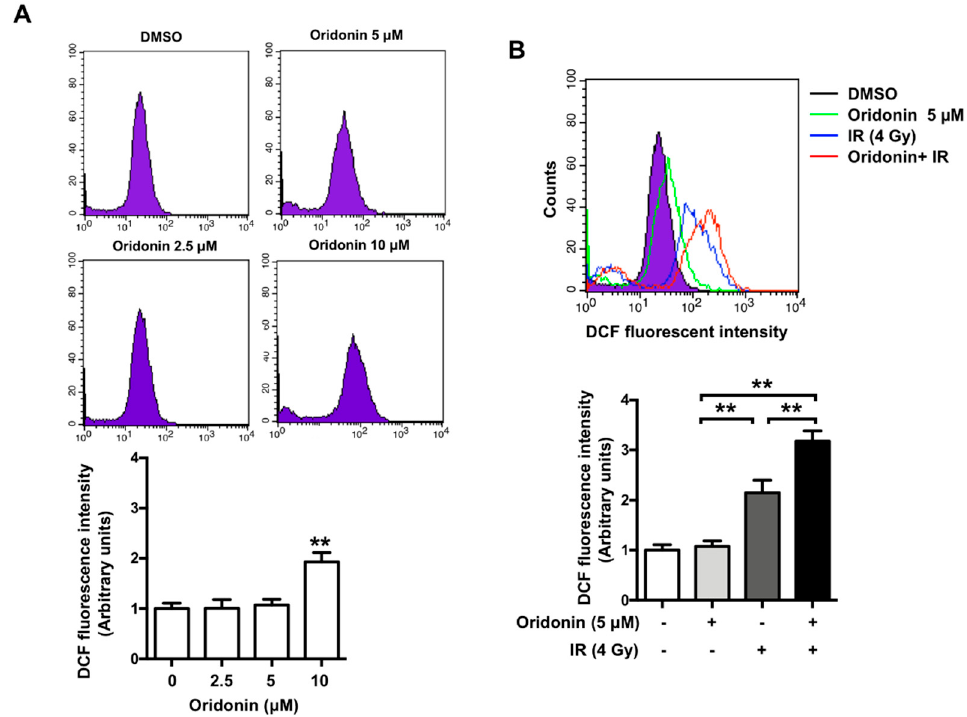
Figure 3. The effect of oridonin on radiation-induced ROS accumulation. ( A ) Cellular reactive oxygen species (ROS) levels were determined by DCFH-DA staining 48 h after treatment with oridonin (0 µM to 10 µM). DCFH-DA fluorescence was measured by flow cytometry. ( B ) Univariate histogram plots represent DCF mean fluorescence of control (vehicle, 0.05% DMSO), oridonin (5 µM), IR (4 Gy), and a combination of oridonin and IR ( upper panel ). DCF fluorescence was quantified and values were normalized to the mean fluorescence of the control ( lower panel ). Values are the average of three independent experiments (means ± SEM; ** p < 0.01). DCFH-DA, 2 ′ ,7 ′ -dichlorodihydrofluorescein diacetate; DMSO, dimethyl sulfoxide.